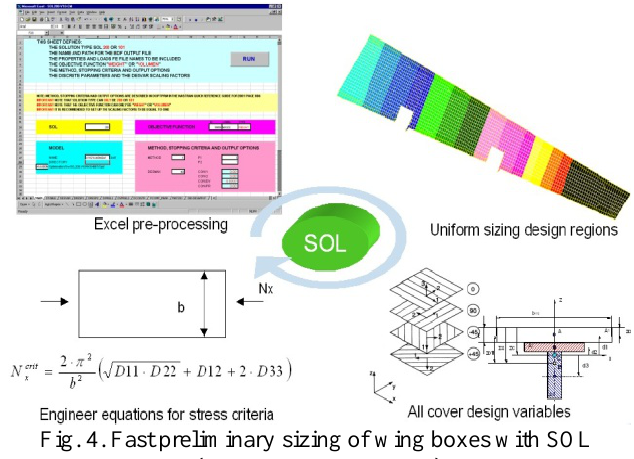
Fig. 4. Fast preliminary sizing of wing boxes with SOL (SOL200 customization)